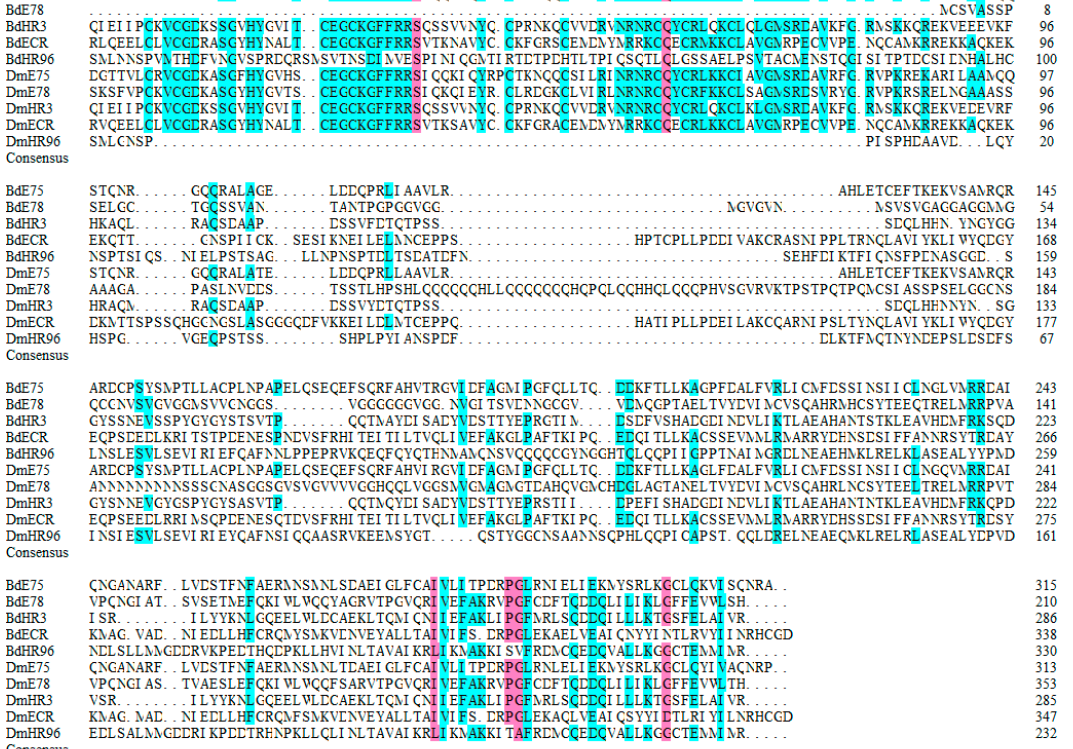
Figure 7. Conserved regions in the NR1 subfamily of B. dorsalis and D. melanogaster NR proteins. Amino acid sequences of the catalytic domains of the NR1 subfamily were aligned using DNAMAN 6 (https://www.lynnon.com/downloads.html). Identical and highly conserved amino acids are indicated by black (100%), pink (75%), and blue (50%), respectively.